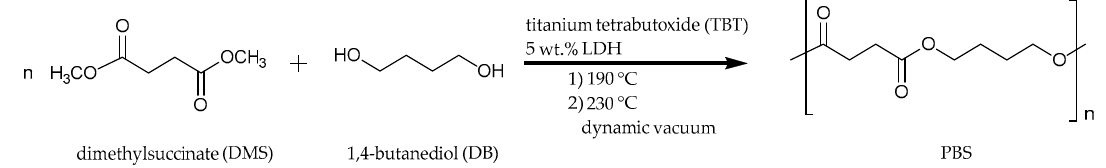
Table 1. Gel permeation chromatography (GPC) and thermogravimetric analysis (TGA) results of PBS, PBS:ferulic acid (FA)/protocatechuic acid (PA) and PBS:Zn 2 Al/X